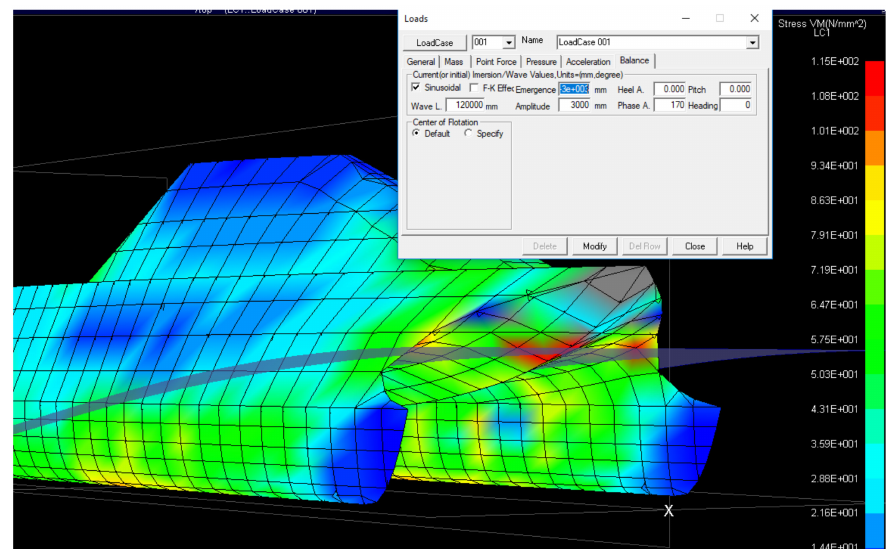
Figure 12. Applied wave specifications for FEA model.